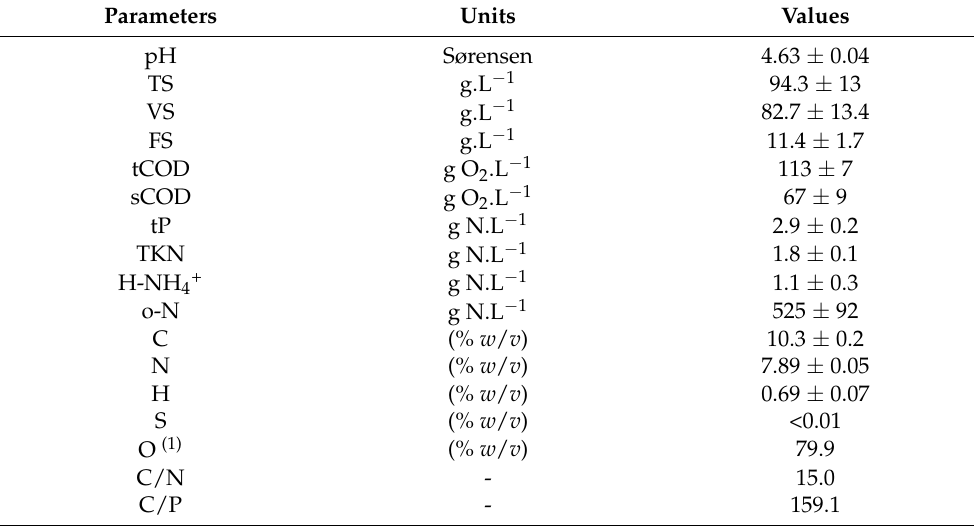
Table 1. Characterization of the OFMSW (average ± standard deviation; n = 10